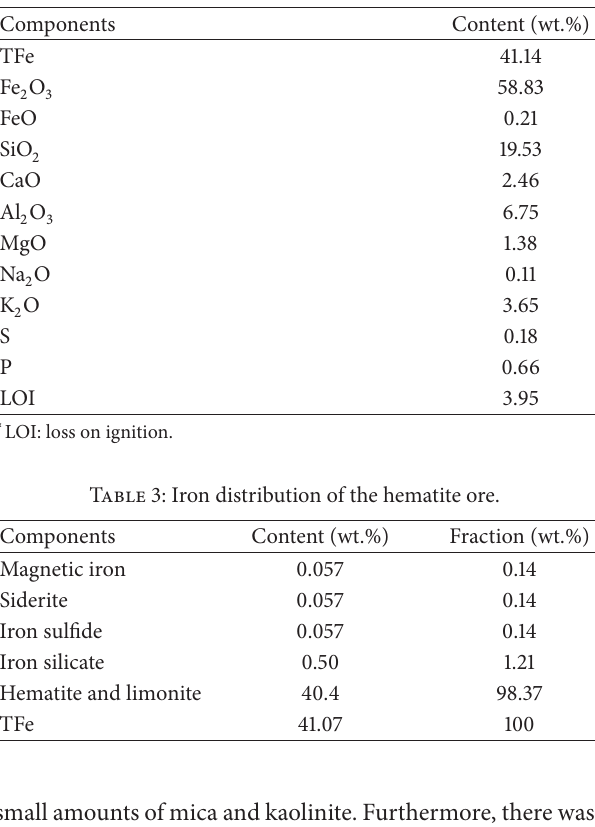
Table 2: Chemical composition of the hematite ore.